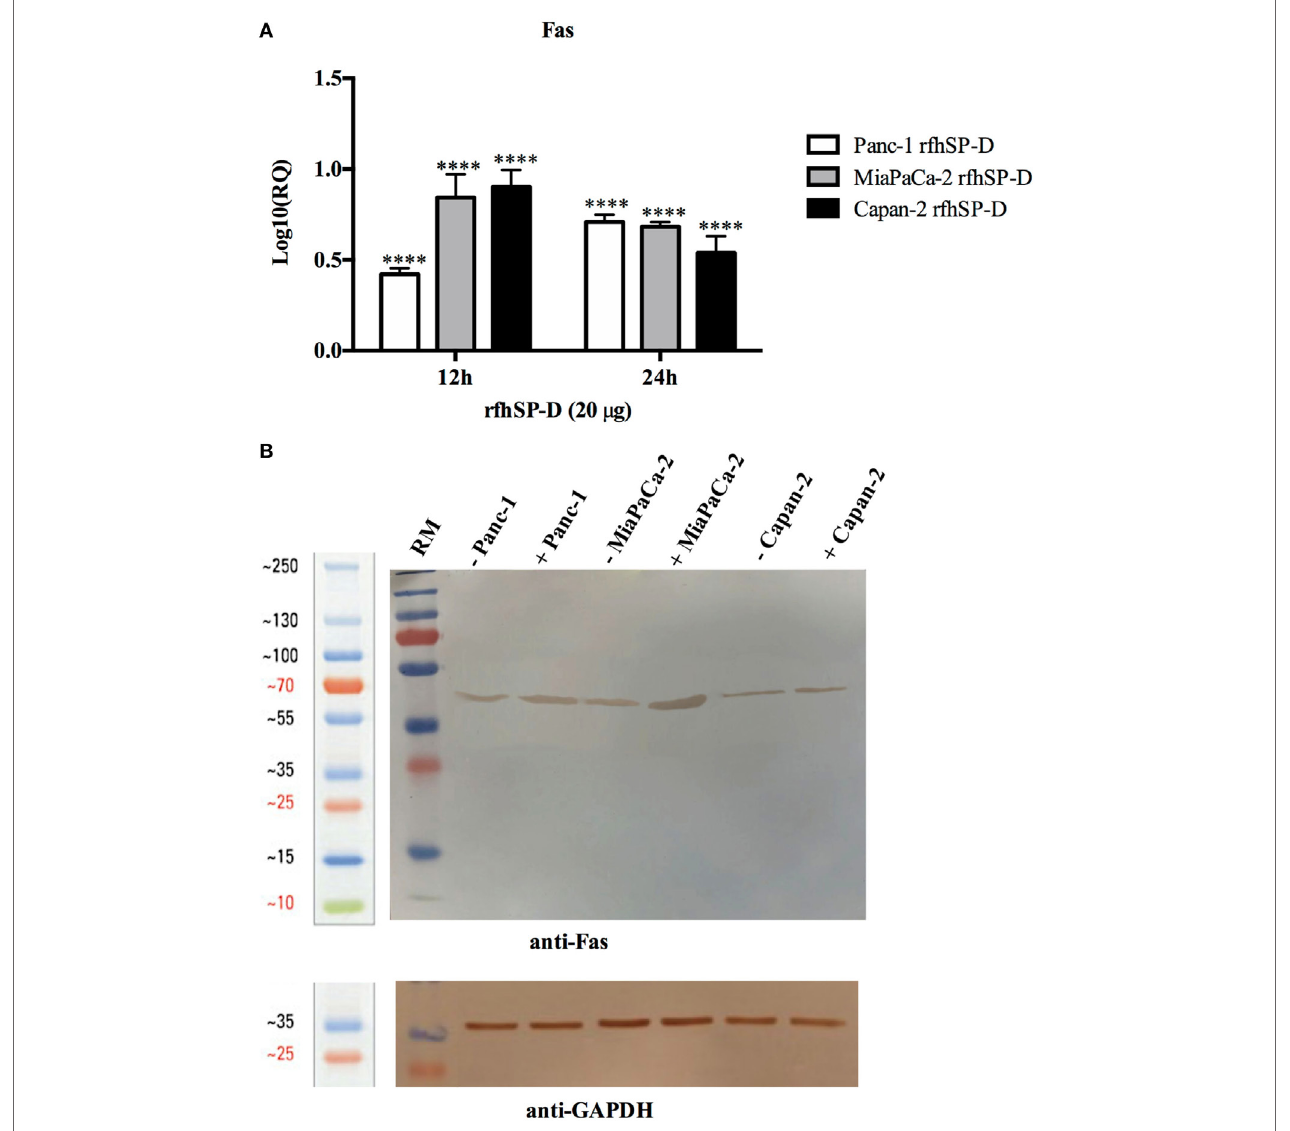
FigUre 5 | Relative quantification (RQ) of Fas mRNA expression in Panc-1, MiaPaCa-2, and Capan-2 cell lines treated with rfhSP-D (20 µg/ml) for 12 and 24 h. (a) Fas expression was upregulated in the treated samples at 12 and 24 h as compared to untreated cells. Significance was determined using the unpaired two-way ANOVA test (**** p < 0.0001) ( n = 3). (b) Fas expression via western blot analysis in pancreatic cell lines treated with rfhSP-D for 24 h using rabbit anti-human Fas (1:1,000) at 4°C overnight, followed by incubation with secondary anti-rabbit IgG HRP-conjugate (1:1,000) for 1 h at room temperature. The bands were